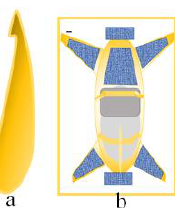
Figure 6 . Basic model vertical view and physical dimensions.